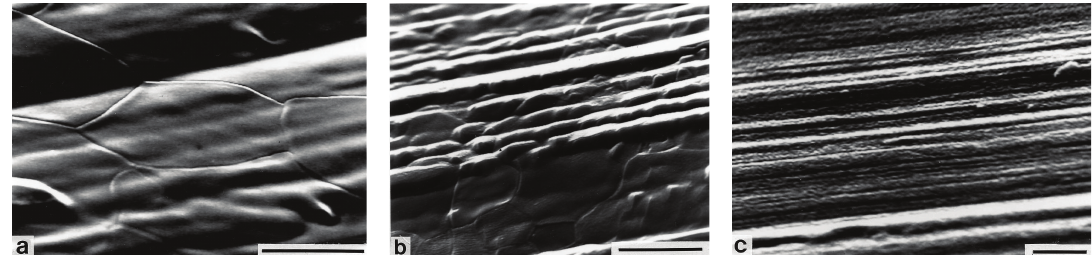
Figure 1: SEM images showing the surface topography of the samples (a) glow discharge cleaned and thermally oxidized sample. Bar = 5 𝜇 m; (b) glow discharge cleaned and nitrided sample. Bar = 5 𝜇 m; (c) hydrogen peroxide treated sample. Bar = 2 𝜇 m.